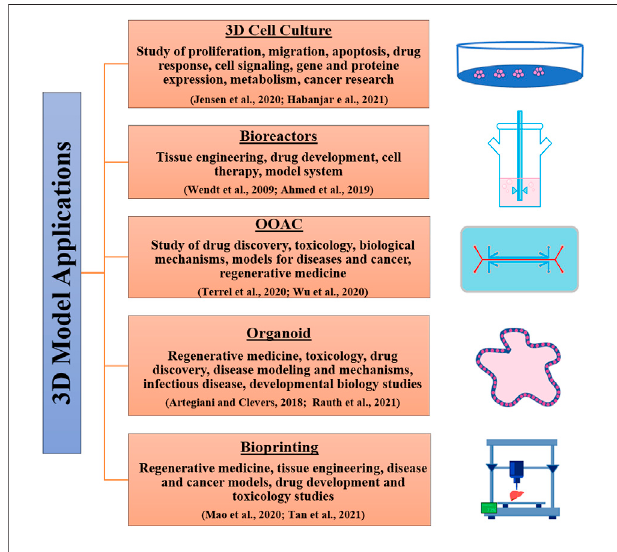
FIGURE 2 | 3D culture systems and their